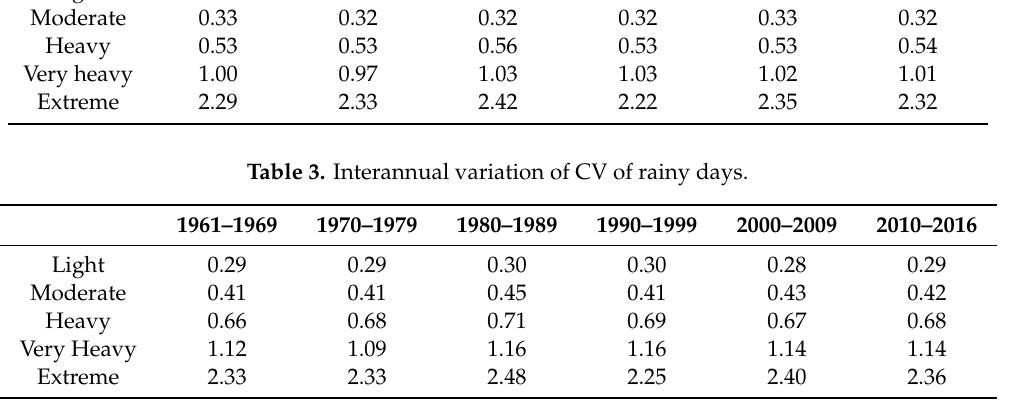
Figure 3. Interannual variation of precipitation in Huang-huai-hai River Basin.